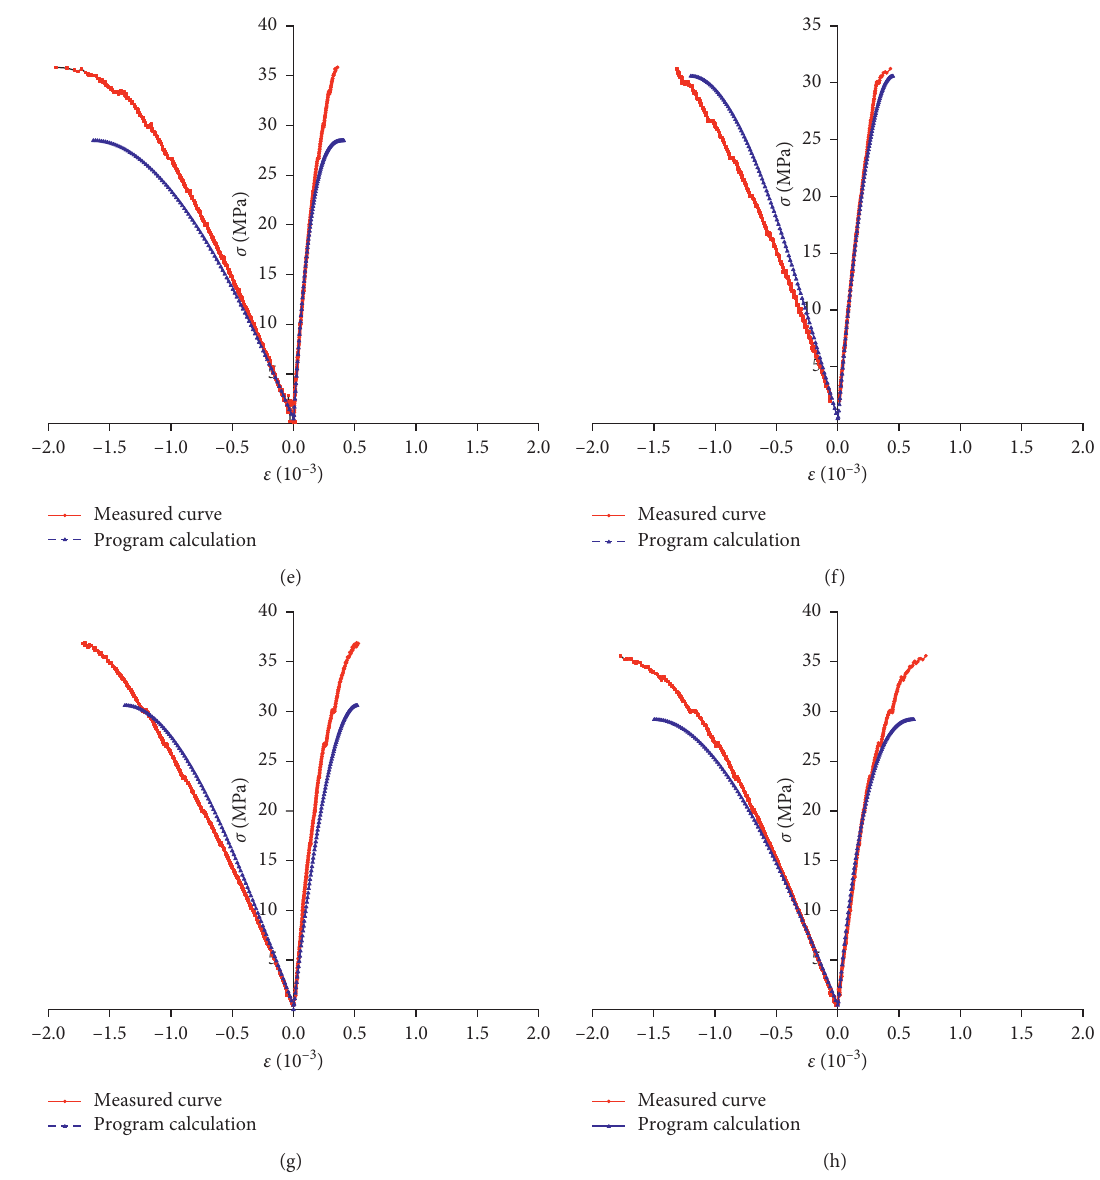
Figure 5: Comparisons between the model predicted stress-strain curves and measured curves. (a) ZS1. (b) ZS2. (c) ZS3. (d) ZS4. (e) ZS5. (f) ZS6. (g) ZS7. (h)